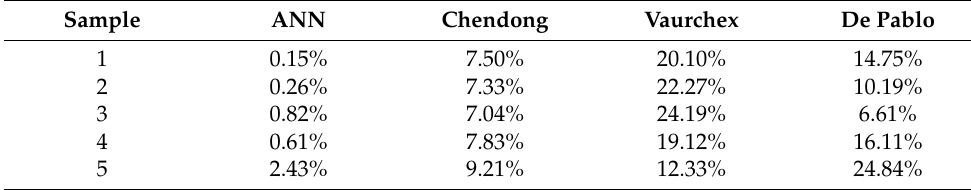
Table 5. Transformer case studies: Error